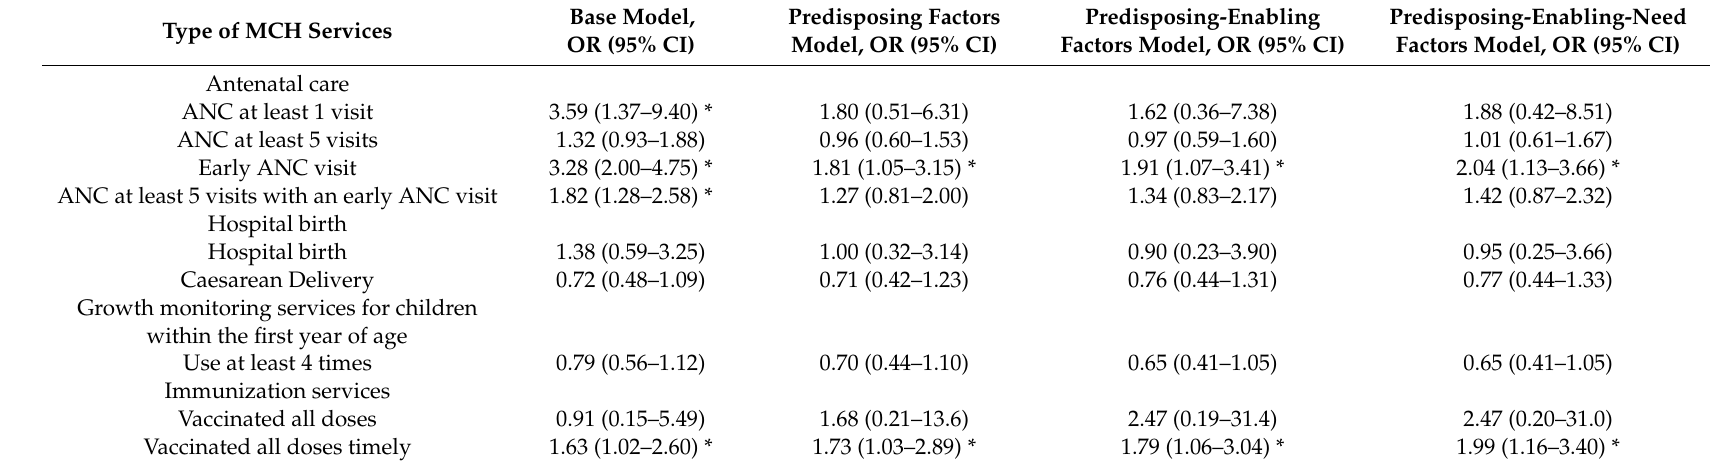
Table 3. Ethnic minority women compared to Han women odds ratio (OR) of inadequate MCH utilization and adjusted odds ratio (aOR) controlling for predisposing, enabling, and need